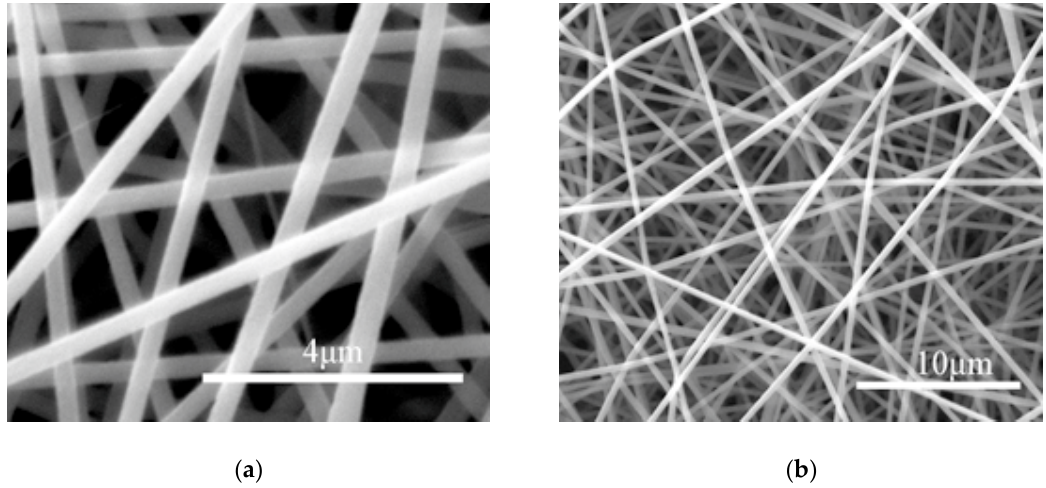
Figure 2. ESEM topography of electrospun fiber at different voltages and PAN mass fraction of 12%. ( a ) ESEM image of the electrospun fiber at 12 kV; ( b ) ESEM image of the electrospun fiber at 22 kV. Scale bars: (a) 4 μ m; (b) 10 μ m.